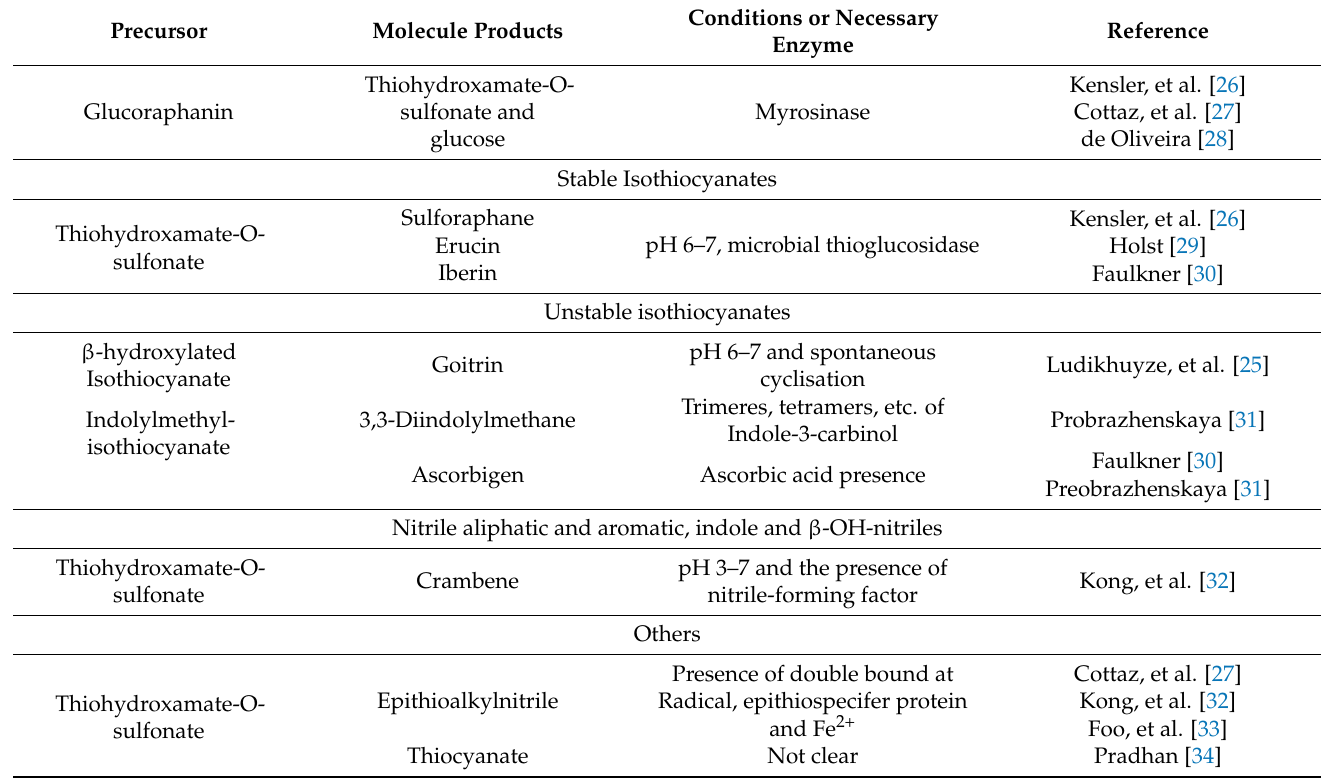
Table 1. Precursors and products of